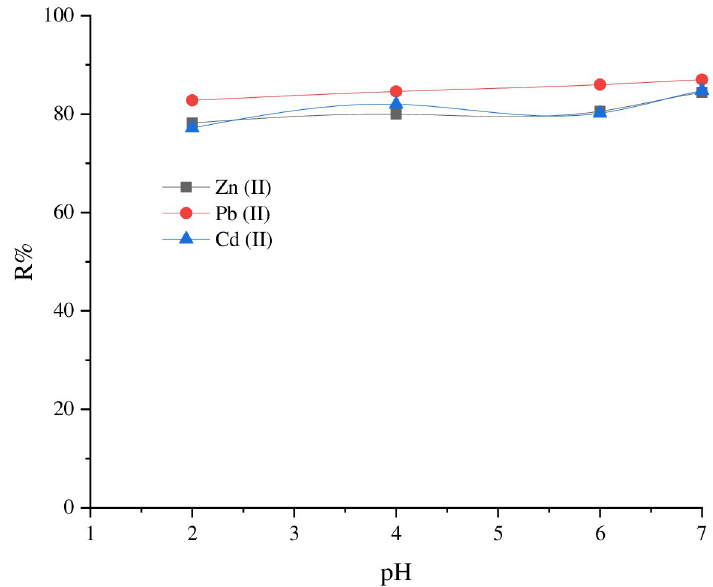
Fig 9. The pH effect on the SnCaAl 2 O 3 nanoparticles’ adsorption of Zn +2 , Cd +2 , and Pb +2 , at constant adsorbent dose, initial concentration of ions, contact time, and volume of polluted water.